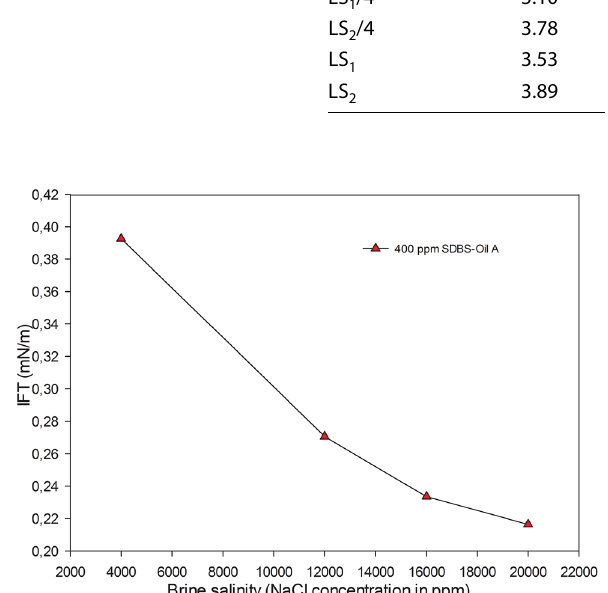
Table 8 The 𝛤 values at different salinity conditions calculated by the Eq. (1)